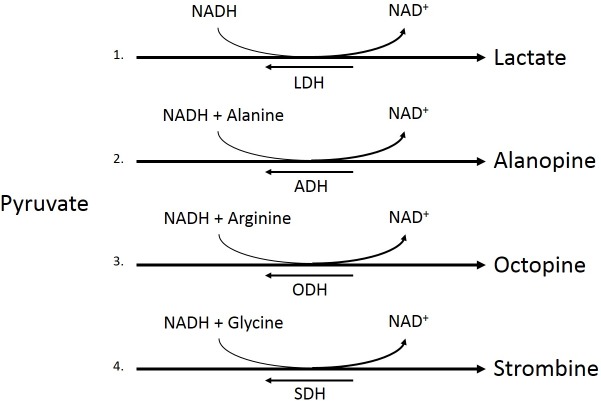
Pyruvate metabolism pathways.Conversion of pyruvate to lactate by lactate dehydrogenase (LDH, 1), pyruvate and alanine to alaopine by alanopine dehydrogenase (ADH, 2), pyruvate and arginine to octopine by octopine dehydrogenase (ODH, 3), and pyruvate and glycine to strombine by strombine dehydrogenase (SDH, 4).